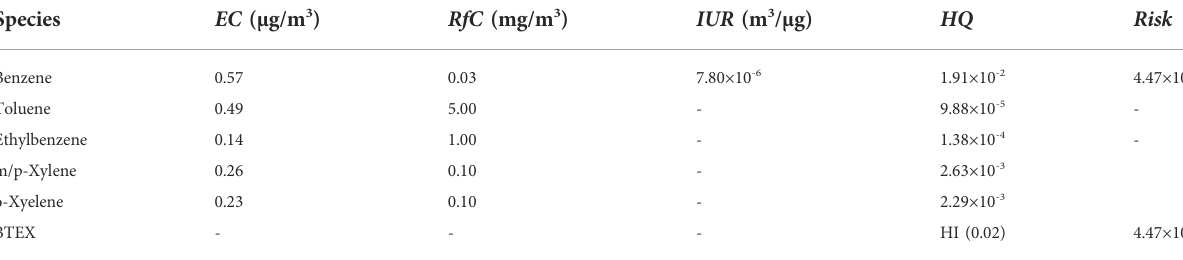
TABLE 4 Health risks of BTEX in